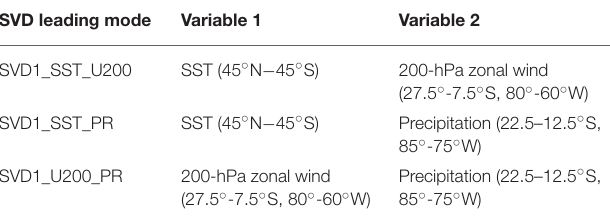
TABLE 3 | List of SVD analyses performed including the variables and domains involved and the names given to each leading